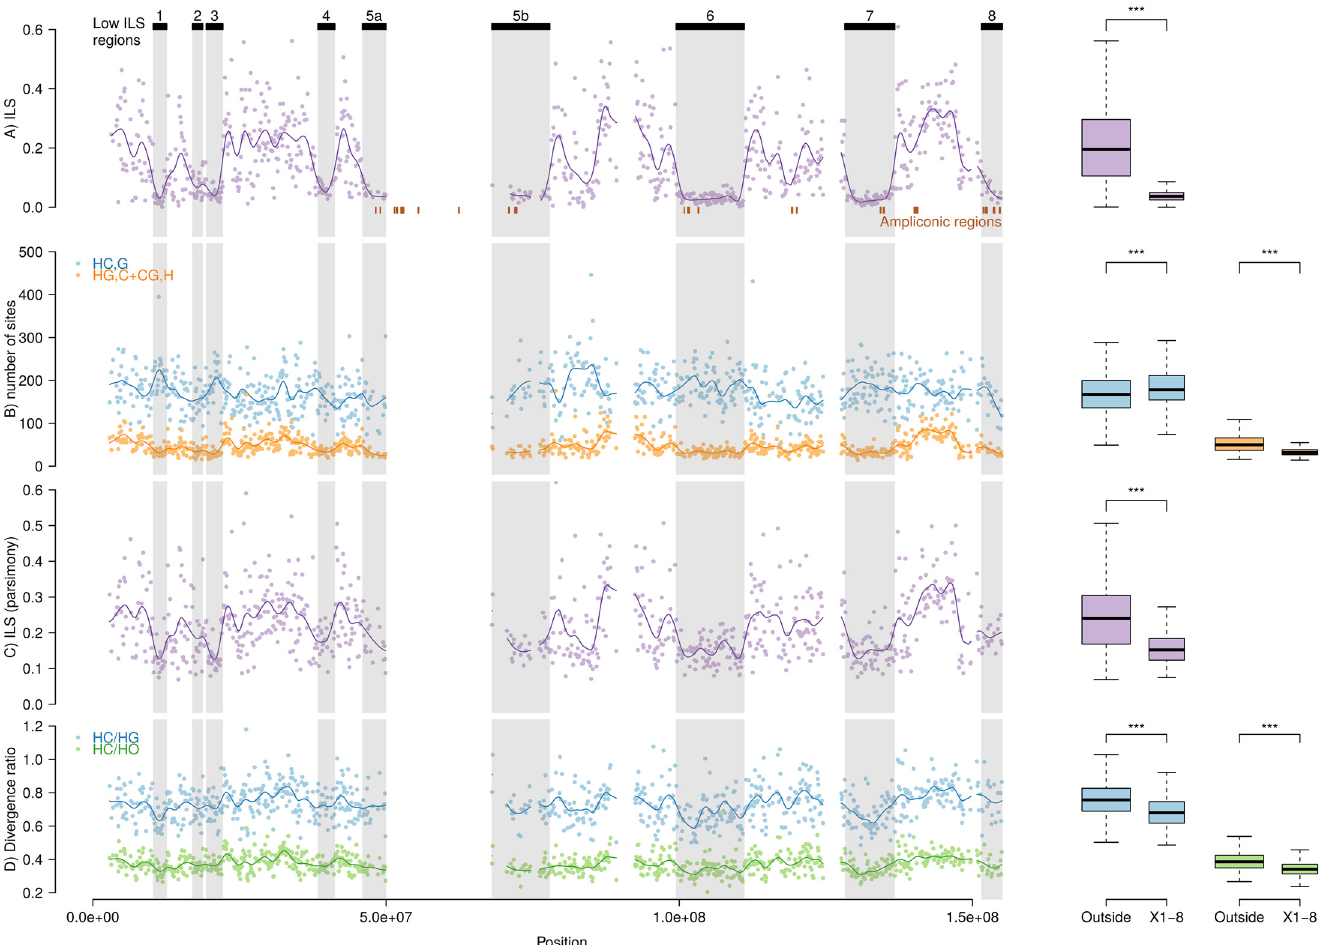
Fig 2. Patterns of incomplete lineage sorting along the X chromosome. Graphs on the left show variation along the chromosome, graphs on the right contrast the distribution of low-ILS regions vs. the rest of the chromosome. Significance codes are according to Wilcoxon rank test. Rows: (A) Proportion of inferred ILS in individual non-overlapping 100 kb windows and a fitted spline. Inferred regions with low ILS are shown on top, and reported on all figures. (B) Frequencies of parsimony informative sites in 100 kb windows, supporting both the canonical genealogy (HC),G and the alternative ones (HG),C and (CG),H together. (C) ILS as estimated by the proportion of parsimony informative sites supporting an alternative topology. (D) Ratio of divergences HC/HG and HC/ HO estimated in 100 kb